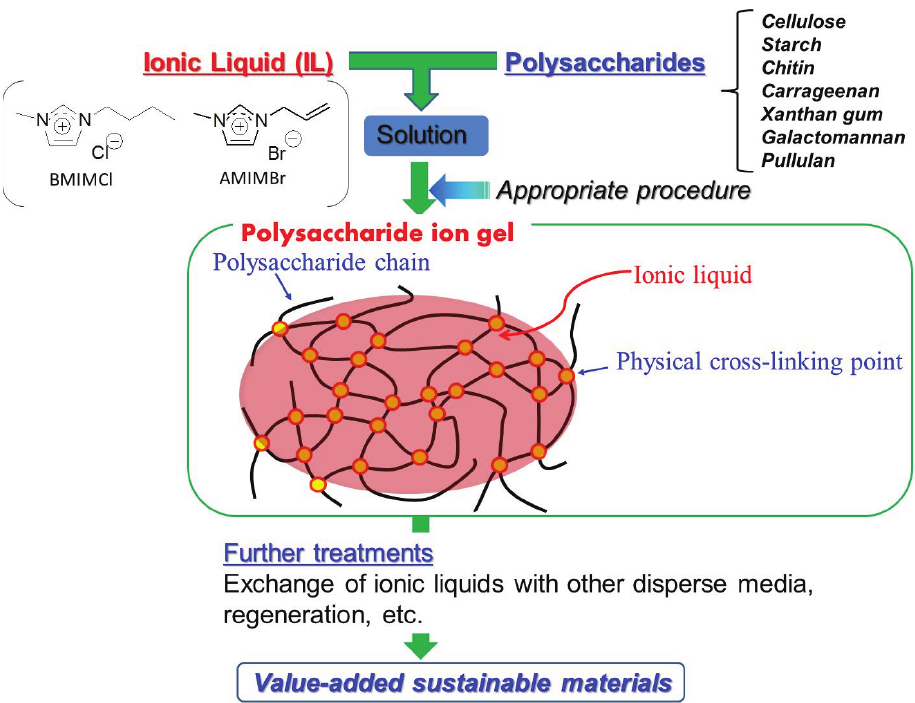
Figure 3. Schematic diagram for procedures of fabrication of polysaccharide ion gels with IL and conversion into value-added sustainable